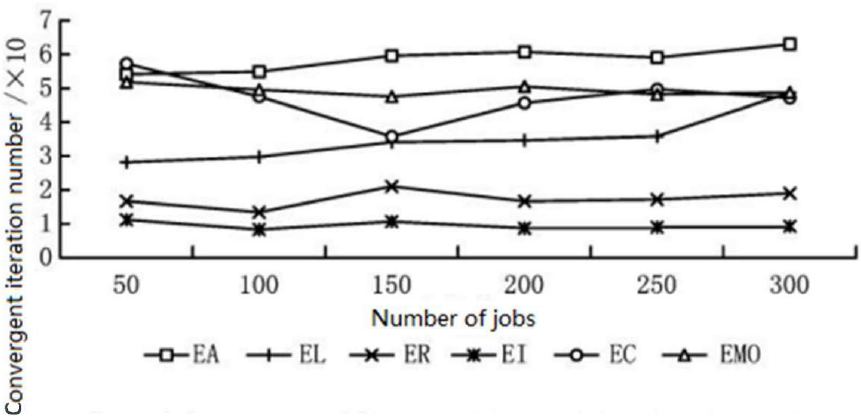
Figure 7. The convergence of the six algorithms. Table 4. The optimal scheduling scheme